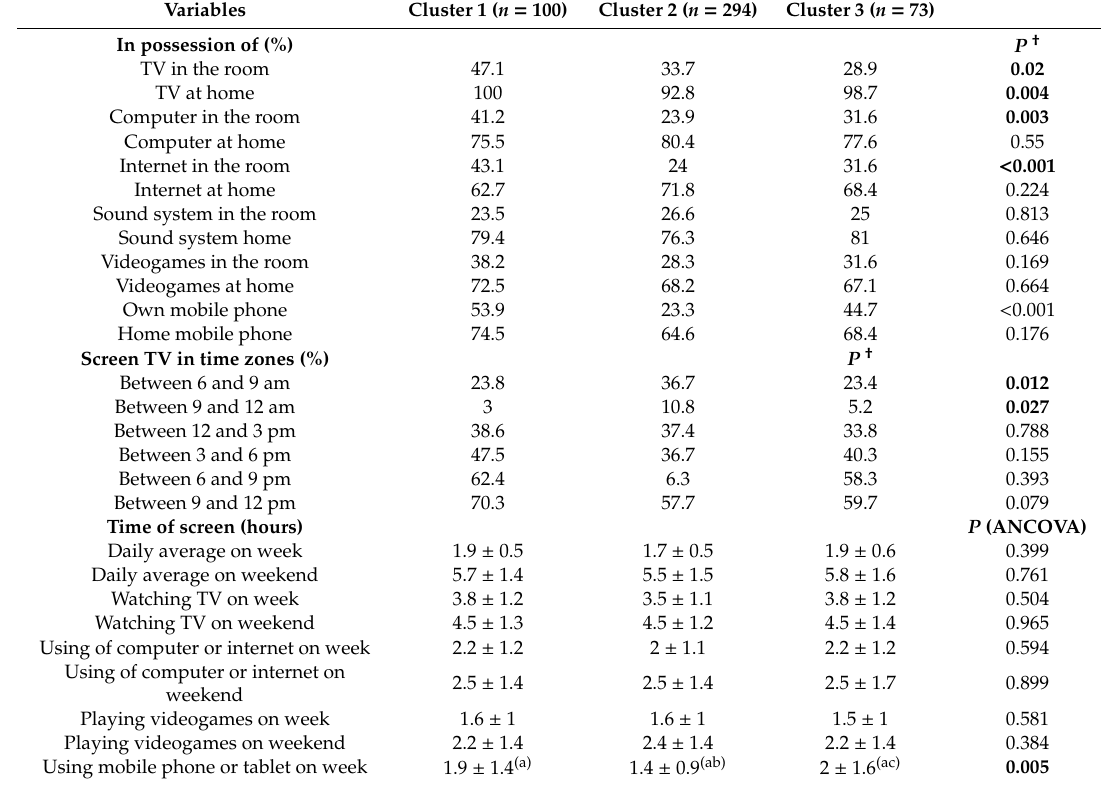
Table 3. Use of electronic devices and screen time by clustering.